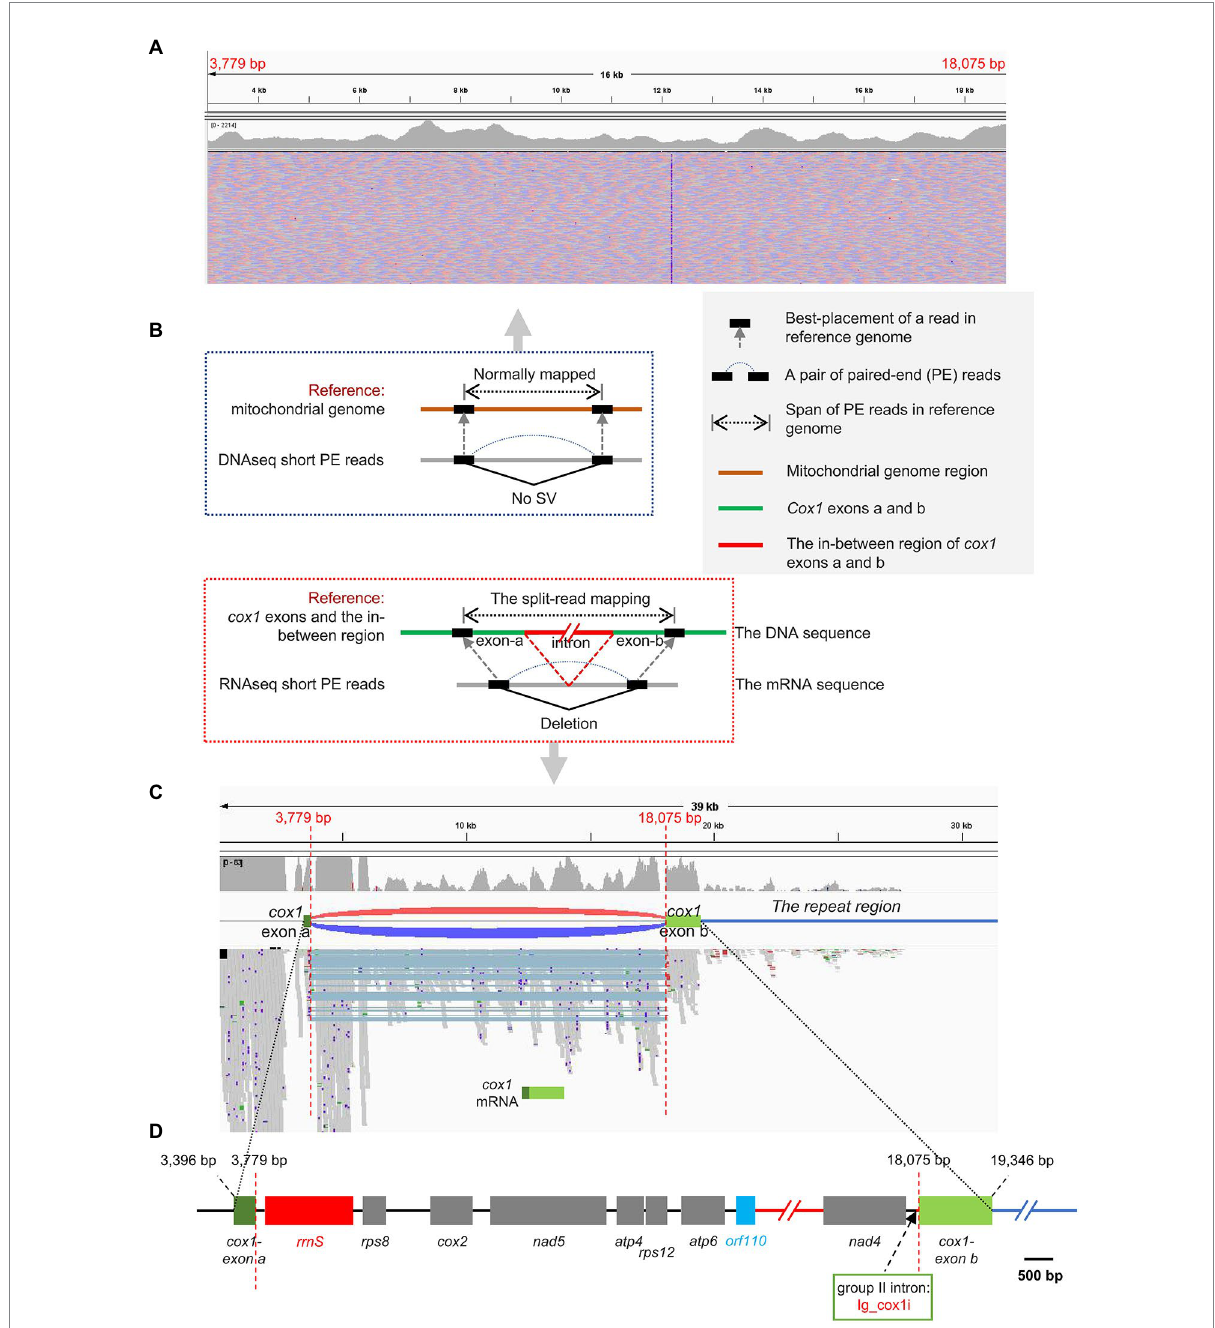
FIGURE 3 The split-mapping strategy to detect the two distantly dispersed exons in cox1 . (A) Visualization of I. galbana mitochondrial genomic architectures by the IGV browser. DNA resequenceing paired-end reads were aligned to the mitochondrial reference genome. The paired-end mapping of high-throughput resequencing data revealed no obvious breakpoint was present at the borders of the exon a and b of cox1 . (B) Principle of using high-throughput and massive paired-end mapping to detect distantly dispersed exons in cox1 . The green lines represent two exons of cox1 in the mitochondrial reference genome. The split-read mapping means reads span across a breakpoint of an SV. (C) Visualization of I. galbana mitochondrial transcriptome architectures by the IGV browser. RNA resequenceing paired-end reads were aligned to the mitochondrial reference genome. The discordant aligned read pairs from two cox1 exons were visualized as red/dark-blue arcs, indicating the presence of deletion, while concordant paired-end reads were normally mapped with no arc in between. The split-mapping paired-end reads in the track contain the same deletion (light blue shades), which is consistent with the discordant pairs by arcs. Four exon borders of cox1 in the reference sequence can be determined by accurate mapping of split reads. The cox1 is the nearest neighboring gene to the repeat region (the dark-blue line). (D) Gene content and order in the region between two cox1 exons in I. galbana mitochondrial genome. A novel gene orf110 with unknown function was identified in the region between two cox1 exons at the position 12,111–12,443. A group II intron designated as Ig_cox1i was found adjacent to exon b of the cox1 gene. The black and dark-blue line represent the intergenic region and the repeat region, respectively. The red line represents a region where a few genes ( cob-nad3-rps3 ) were